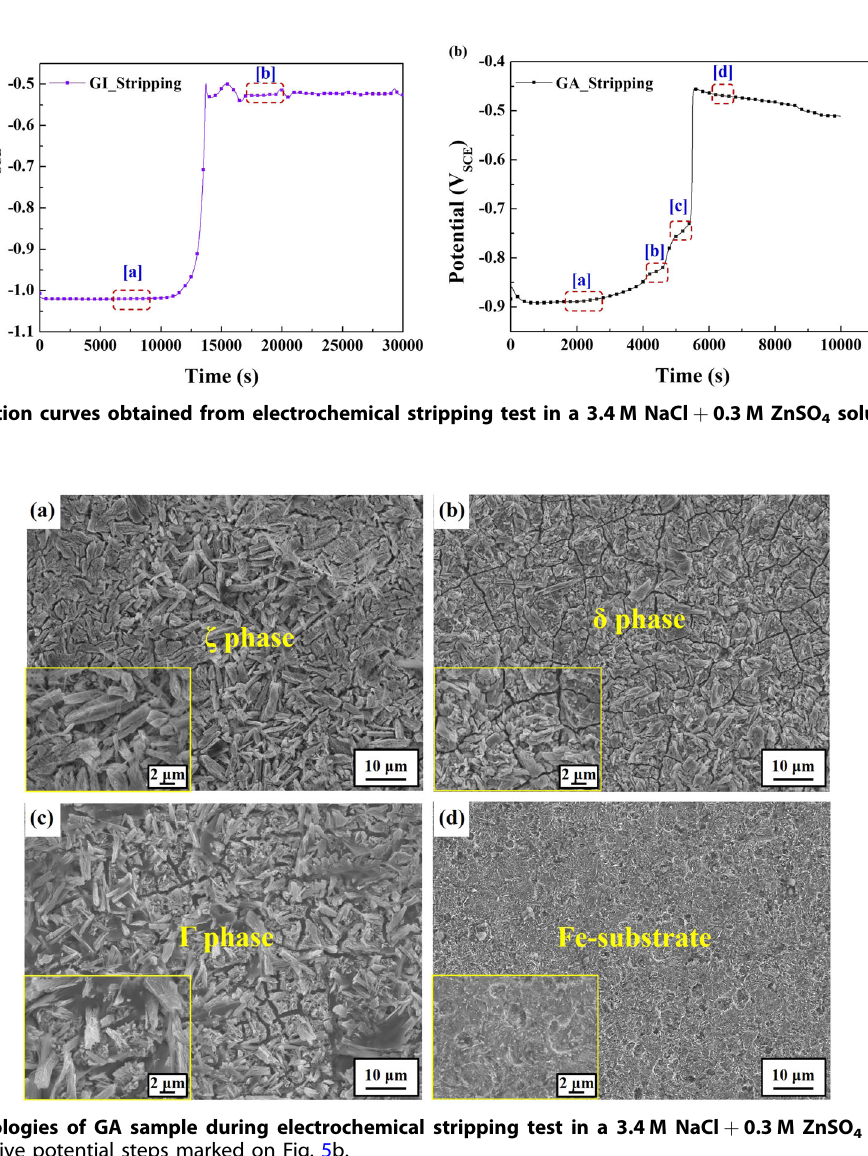
Fig. 4 Electrochemical corrosion behaviors. a Potentiodynamic polarization curves obtained in a 3.5% NaCl + 0.3% NH 4 SCN solution. b Numerical curve- fi tting to a .